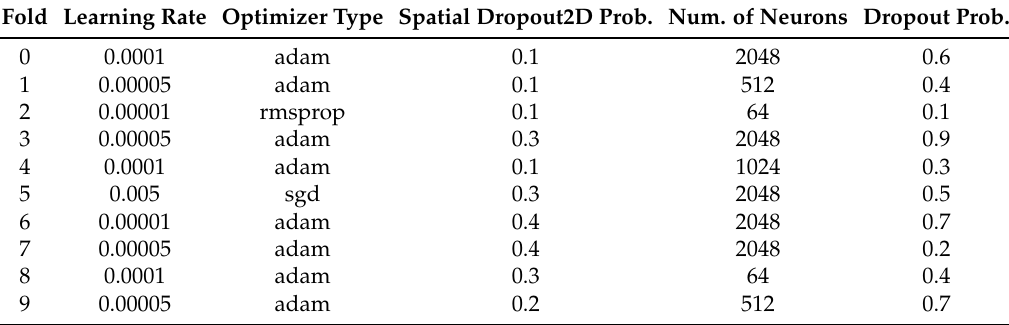
Table 8. Obtained hyper-parameters per fold using the CNN-TL-DE method.